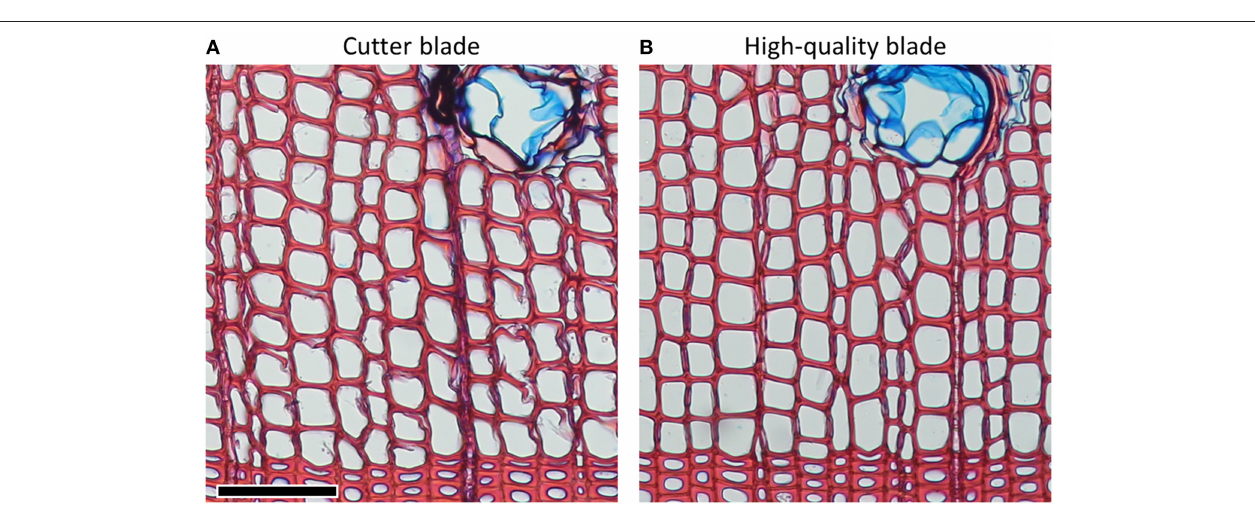
Frontiers in Plant Science |